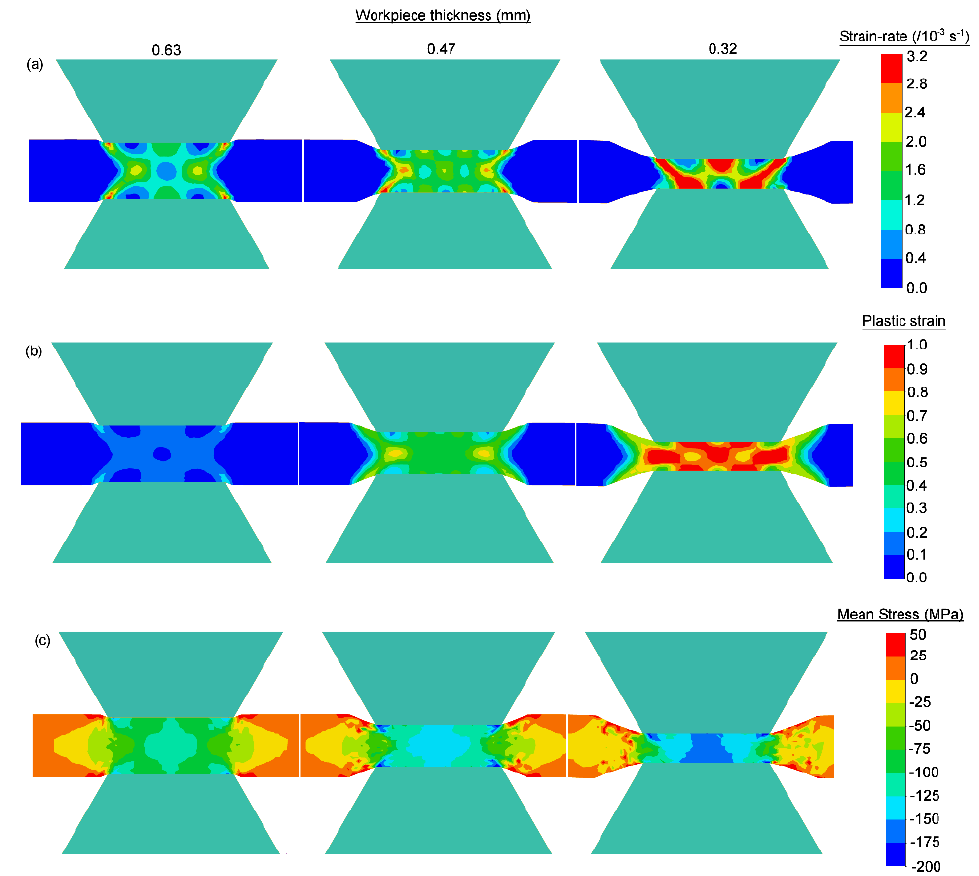
Figure 4. Distribution of ( a ) strain-rate, ( b ) plastic strain, and ( c ) mean stress at different stages of plane strain compression considering 2D conditions.